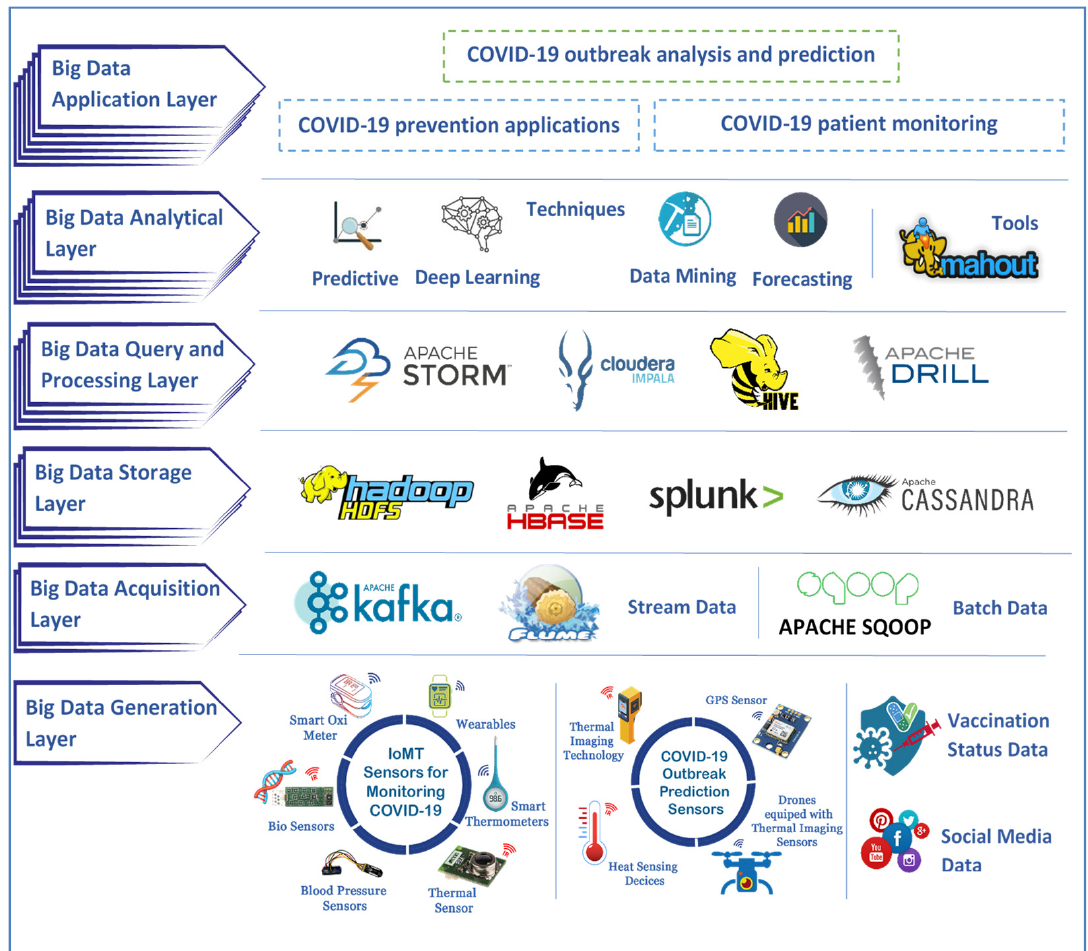
Figure 4. cov-AID—an IoMT based framework, for preventing, monitoring, and predicting outbreak regions of COVID-19.